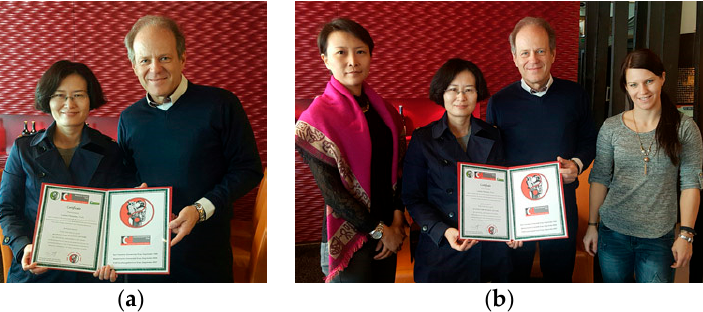
Figure 4. Professor Liang Fengxia and Professor Gerhard Litscher ( a ) From left to right: PD Dr. Lu Wang, Professor Liang Fengxia, Professor Gerhard Litscher, and Dr. Daniela Litscher ( b ) Graz, Austria, 2017.